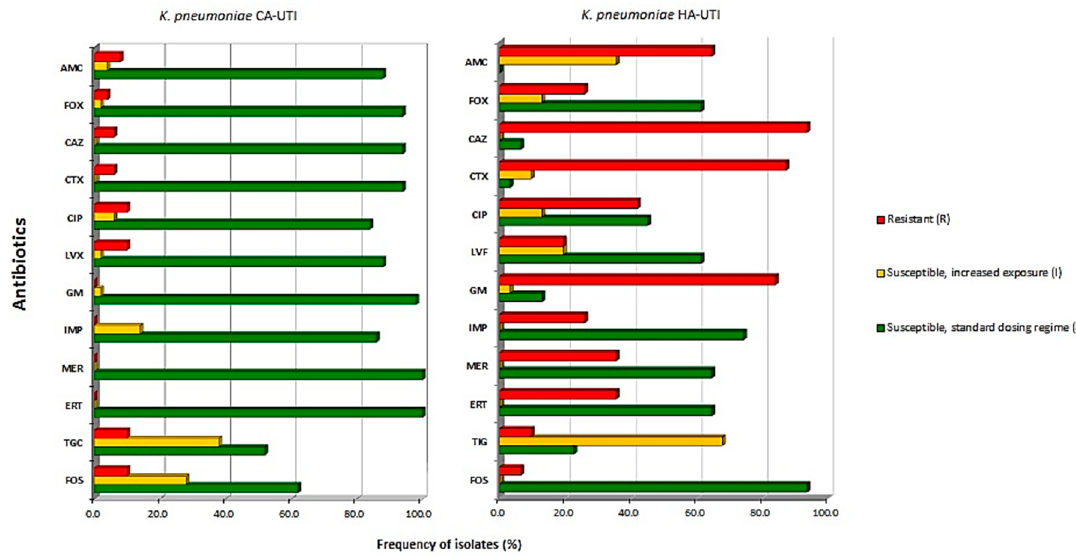
Figure 1. Antimicrobial susceptibilities of the K. pneumoniae clinical isolates (n = 81). The isolates were recovered from community-acquired (CA)-urinary tract infection (UTI) and hospital-acquired (HA)-UTI patients. The CA isolates were consecutively collected while the HA isolates were selected from the FFUL collection based on the source of isolation (urine only), beta-lactamase type produced, and within this, by random selection. Legend: AMC, amoxicillin/clavulanic acid; FOX, cefoxitin; CAZ, ceftazidime; CTX, cefotaxime; CIP, ciprofloxacin; LVF, levofloxacin, GM, gentamicin; IMP, imipenem; MER, meropenem; ERT, ertapenem; TIG, tigecycline; FOS, fosfomycin; FFUL, Faculty of Pharmacy University of Lisboa.